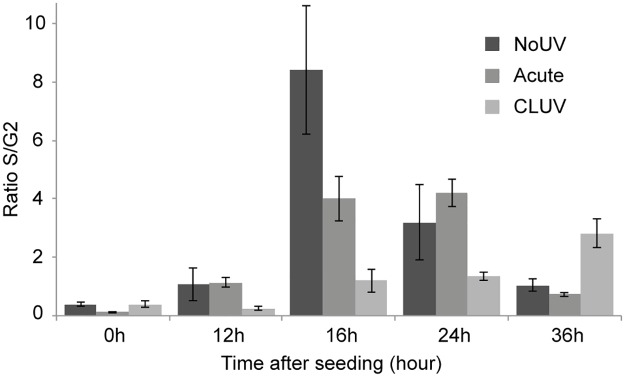
Cell division analysis after single UVB and CLUV irradiation.Cells were either irradiated with either a CLUV treatment (CLUV) or a single UVB dose of 200 J/m2 (Acute). Un-irradiated cells (NoUV) were used as control. Synchronization in G0 was achieved by keeping the cells at full confluency for 12 days and then re-seeded at low density (8.3x103 cells/cm2). S-phase recovery derived as S/G2 ratio was assayed during 36 h using PI staining FACS analysis. Data are presented as means ± SEM using 4 independent cell strains (N = 4).